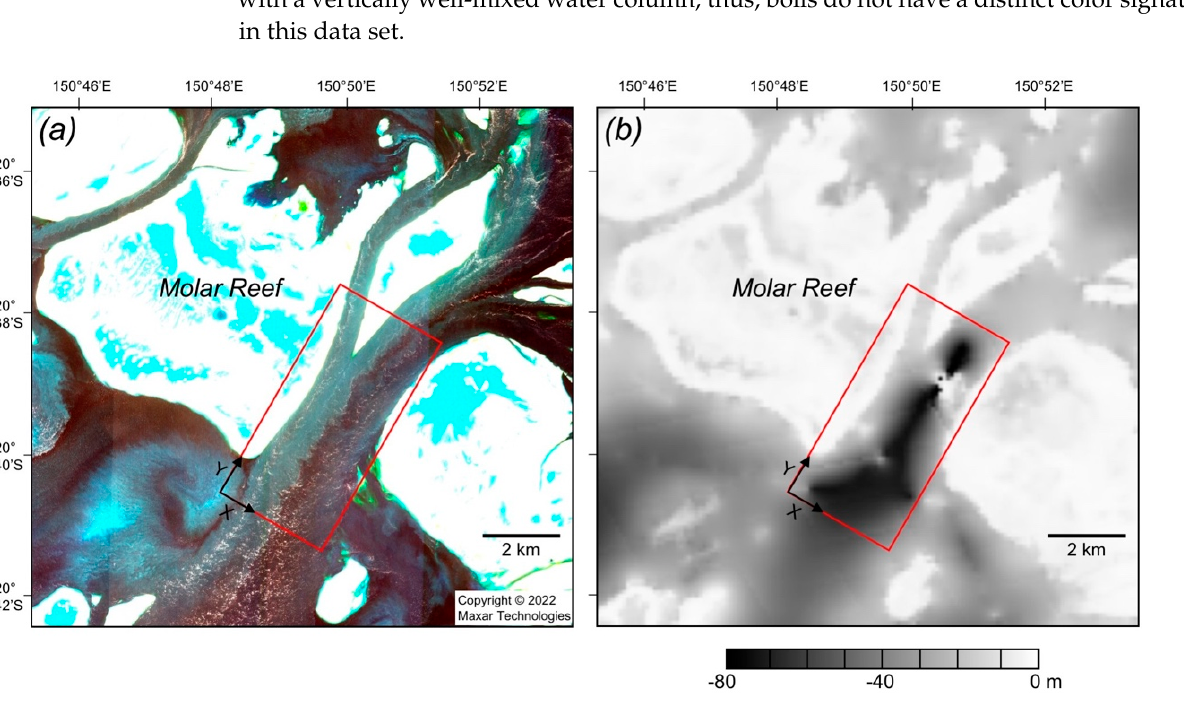
Figure 2. ( a ) Molar Reef as seen by the WorldView-2 satellite at 23:37 UTC 22 August 2020. Shown are data from bands 5, 3, and 2 (red, green, and blue wave lengths) but the color ranges have been stretched to reveal both water surface scattering and water color changes across the channel. Red rectangle shows the analysis area, which is aligned with the main channel between Molar Reef and the unnamed reef lying to the southeast. ( b ) Bathymetry has 100-m spatial resolution [17]. Scale bar indicates depth in meters.